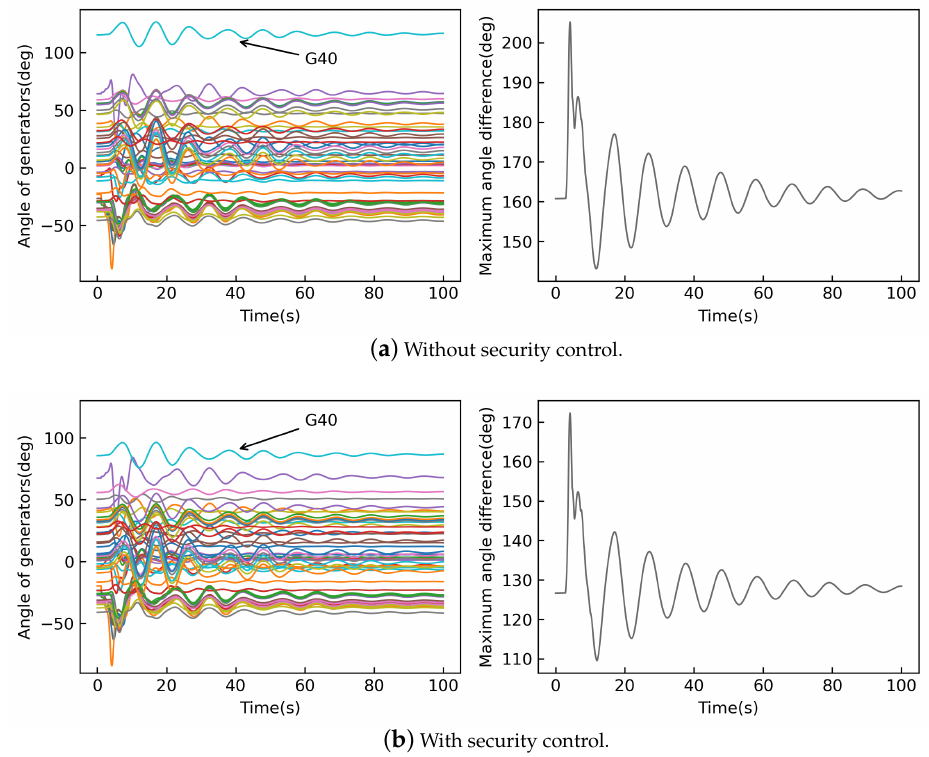
Figure 9. Rotor angles of 54 generators after a specific contingency in the IEEE 118-bus